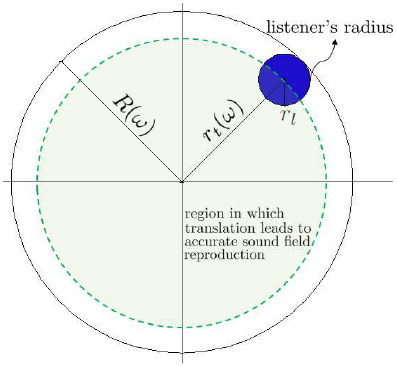
Figure 16. Region of accurate translation given by the PWE.